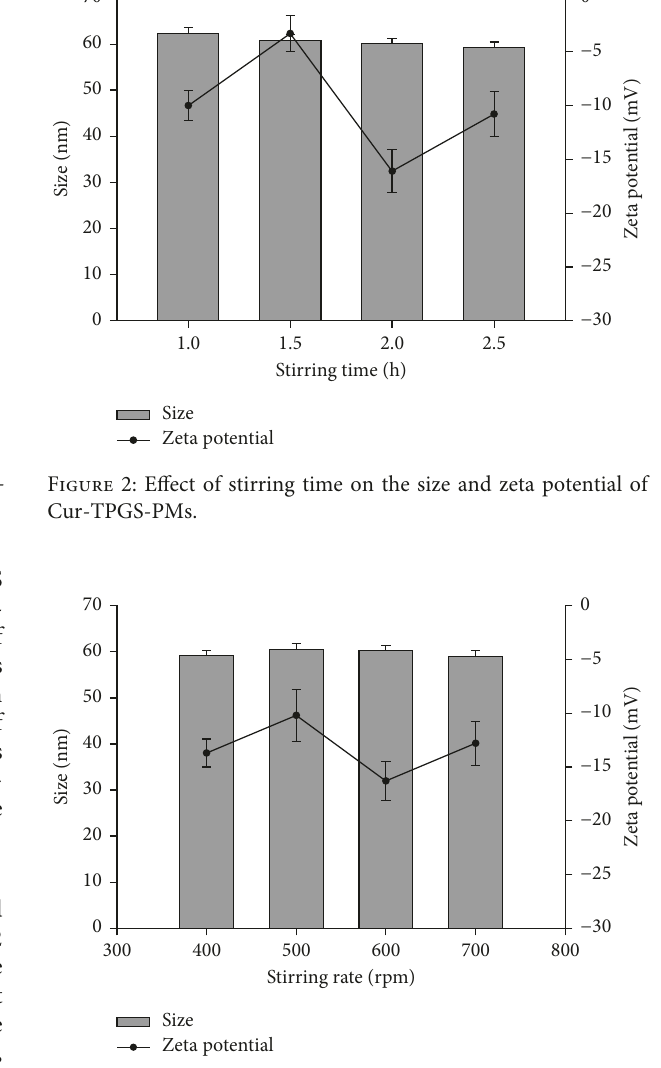
Figure 3: Effect of stirring rate on the size and zeta potential of